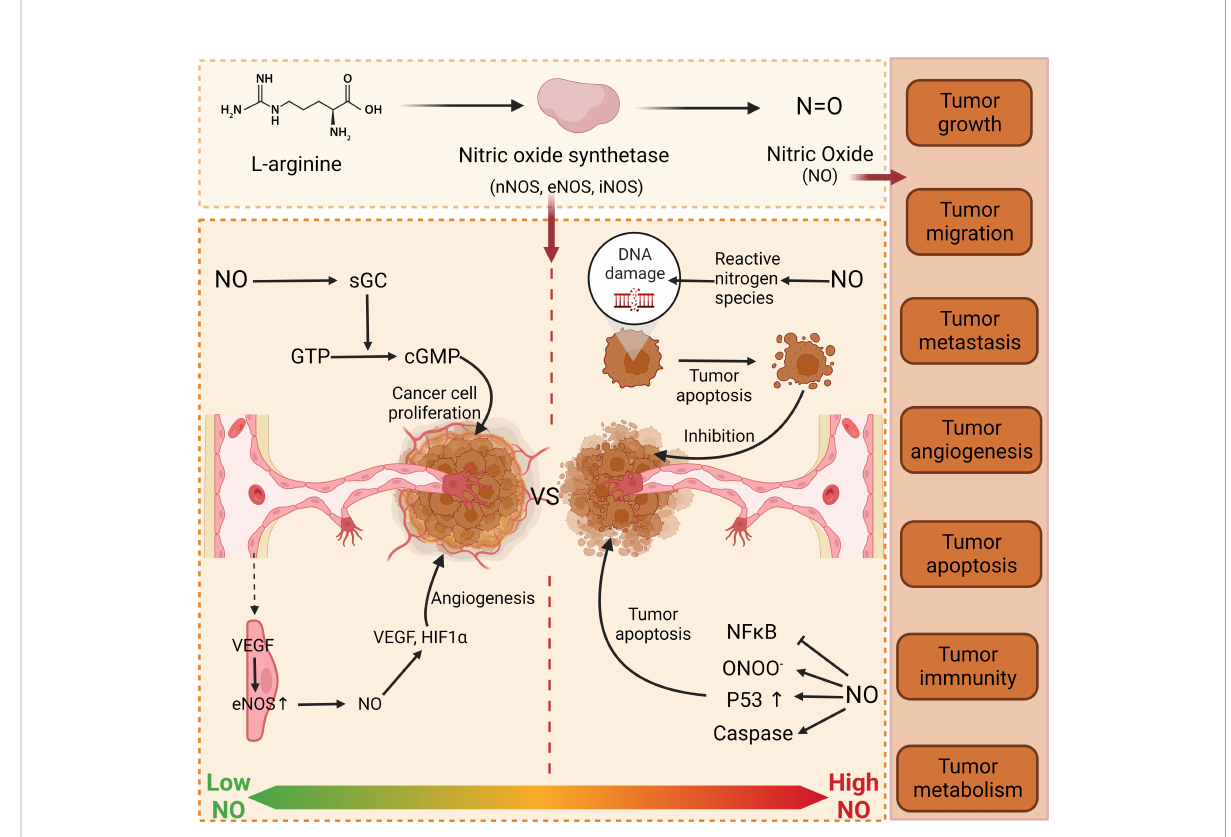
FIGURE 1 Function of NO in cancer. NO has dual properties on tumor cells. At low concentration, NO promotes tumor growth and proliferation through GMP-dependent pathway and angiogenesis. At high concentration, NO destroys the DNA of tumor cells by releasing active nitrogen, thus achieving the purpose of inhibiting tumor cells. Furthermore, NO can also accumulate P53 to affect the physiological processes of tumor cells. nNOS, neuronal nitric oxide synthase; eNOS, Endothelial Nitric Oxide Synthase; iNOS, Inducible Nitric Oxide Synthase; NO, nitrous oxide; sGC, Soluble guanylate cyclase; GTP, Guanosine Triphosphate; cGMP, cyclic guanosine monophosphate; VS, versus; VEGF, Vascular Endothelial Growth Factor; HIF1A, Hypoxia inducible factor-1 a ; DNA, deoxyribonucleic acid; NFkB, nuclear factor k B; ONOO, peroxynitrite